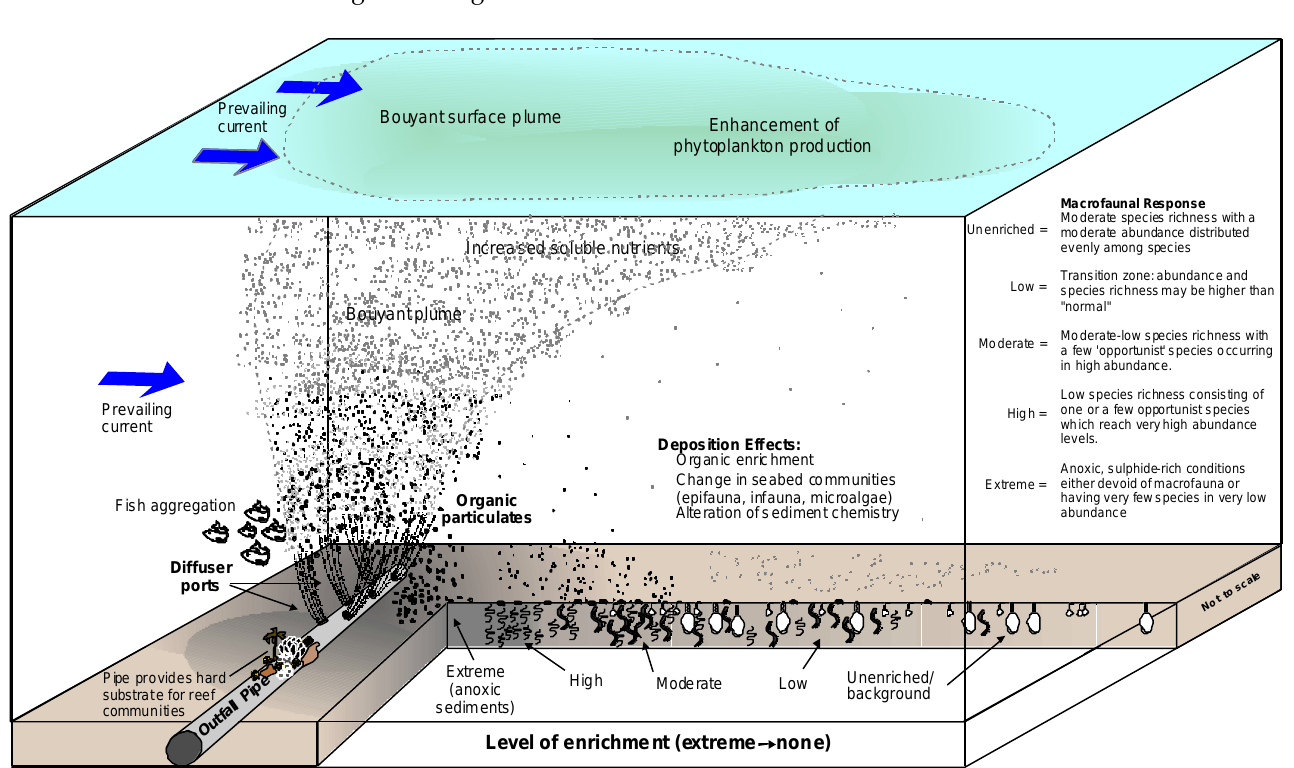
Figure 1. Schematic of potential effects of a submarine wastewater discharge on the water column and a soft bottom habitat. NB. The near field can be considered the area of highest density of organic particulates and fish aggregation near the diffuser ports. The transition zone corresponds to the area of the discharge with the lowest concentration of particulates in the upper water column (labelled as ‘buoyant plume’). The boundary of the far field begins where ambient flow conditions determine plume behavior, in this case where the plume is advected to the right (areas labelled as ‘increased soluble nutrients’).